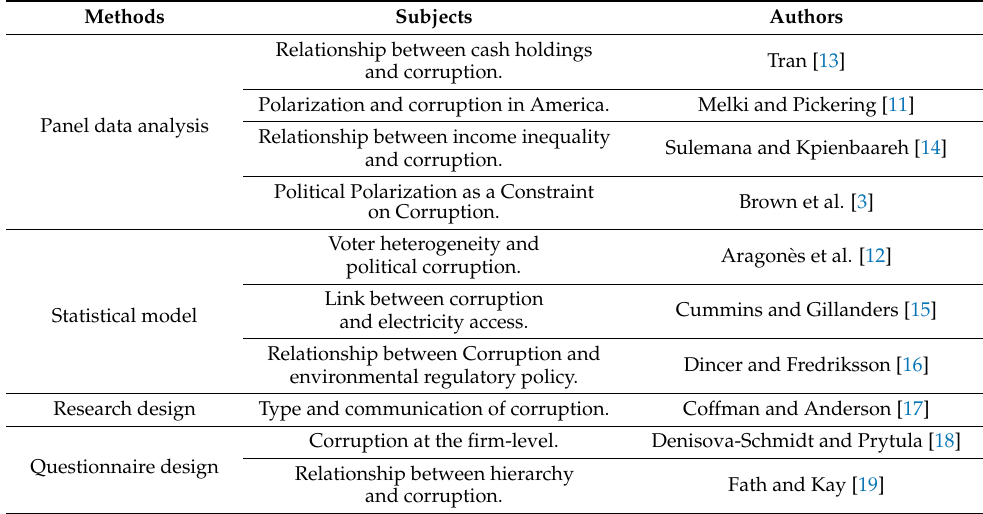
Table 1. Corruption related